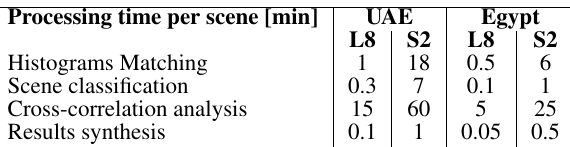
Table 1. Indicative procedure run times (OS: Windows 10 -